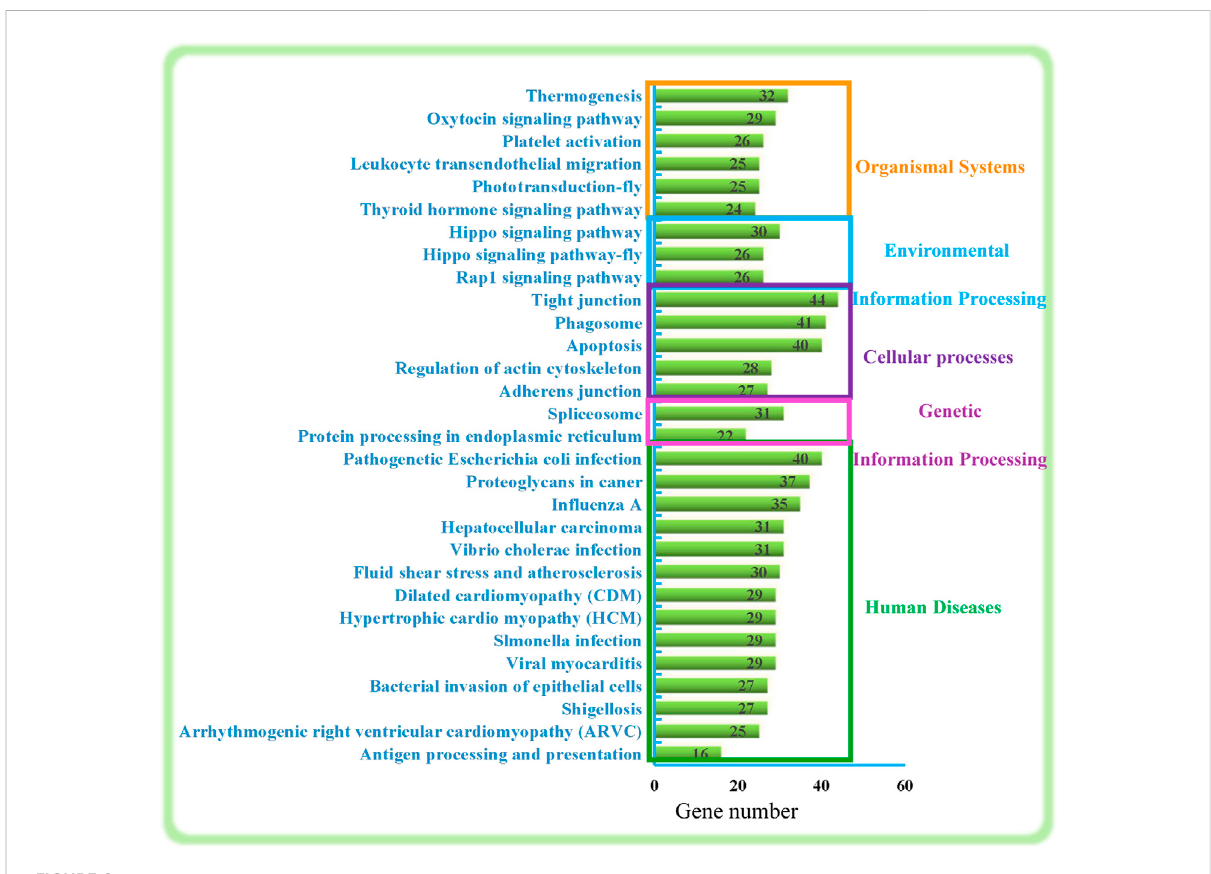
FIGURE 2 Top 30 KEGG pathways. The numbers on the right represent the number of DEGs in each